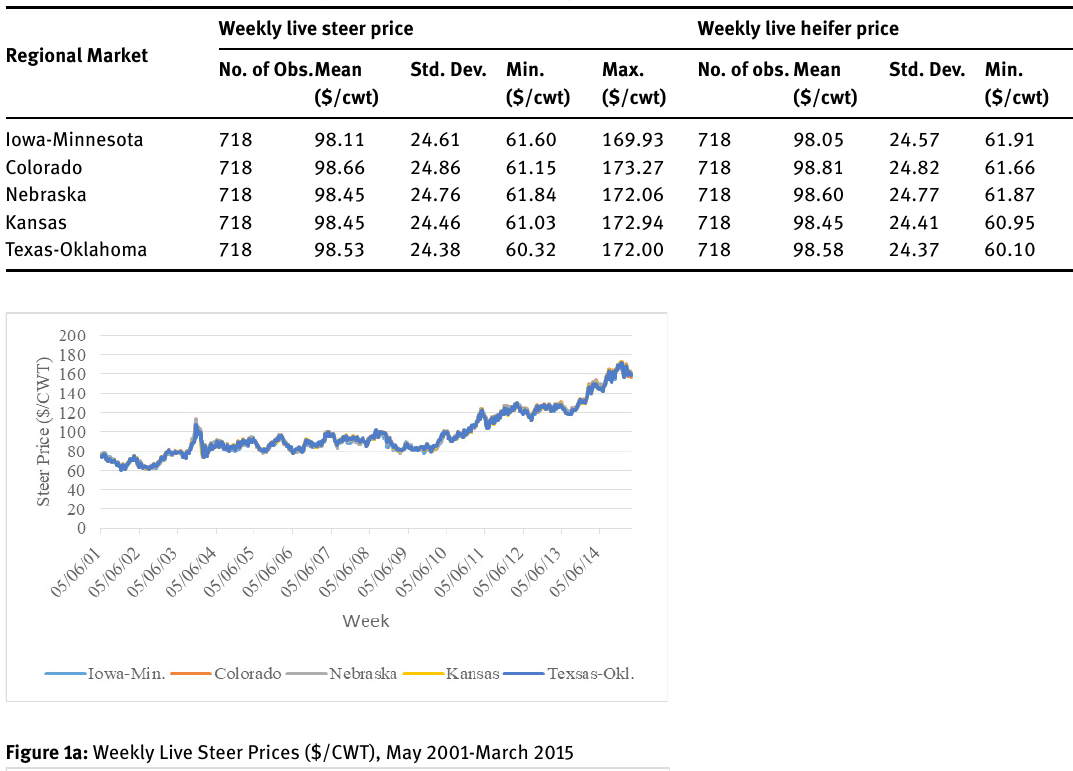
Figure 1a: Weekly Live Steer Prices ($/CWT), May 2001-March 2015